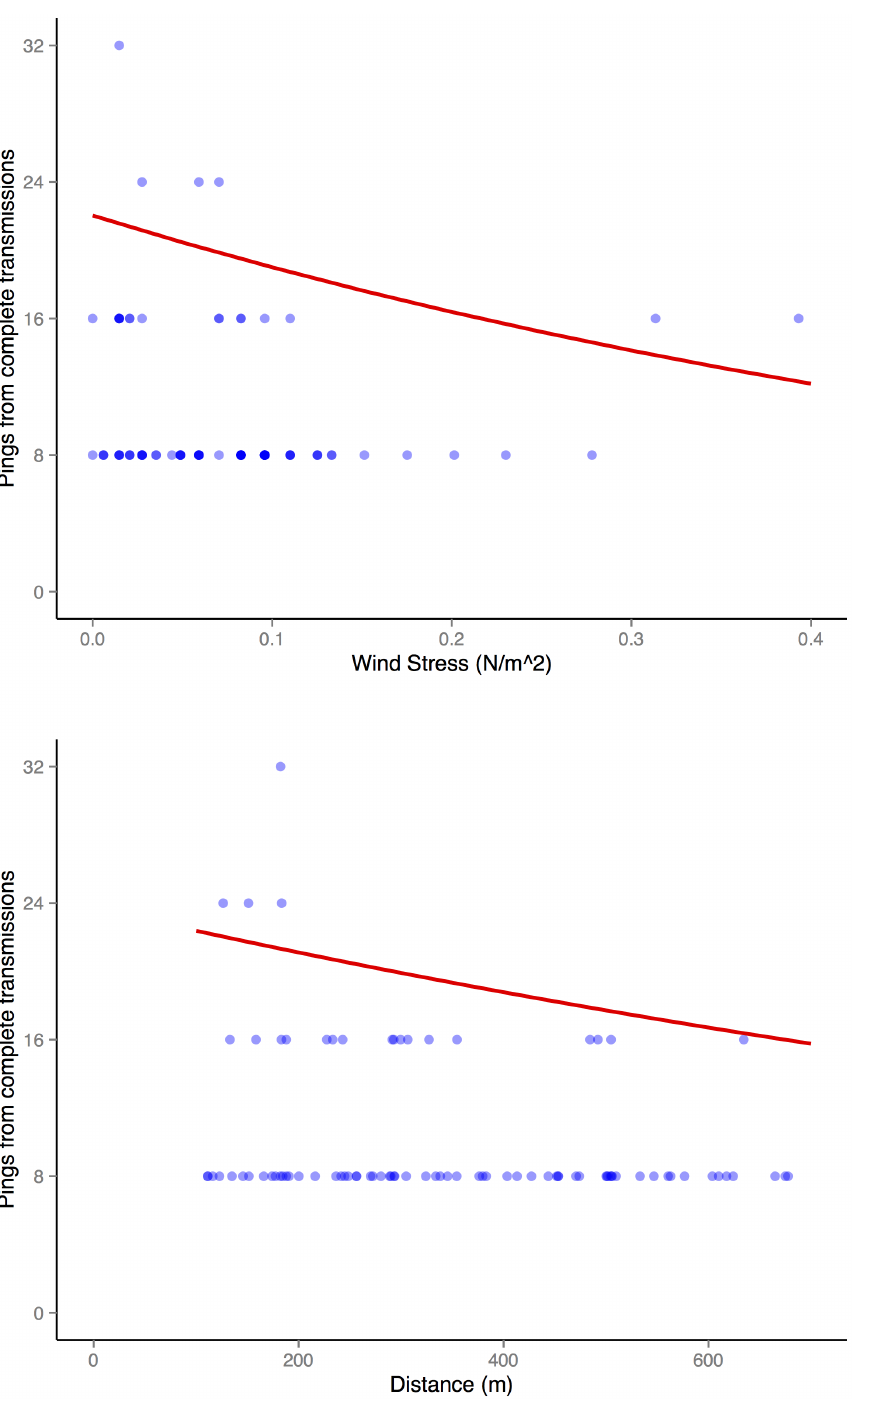
Figure 6. Factors affecting conversion efficiency. The predicted effect on conversion efficiency of the significant variables (red line): wind stress and distance. Fitted values (VMT acoustic pings from complete transmissions offset by total VMT acoustic pings received) as points. Points: dark blue indicates high intensity, light blue indicates low intensity.